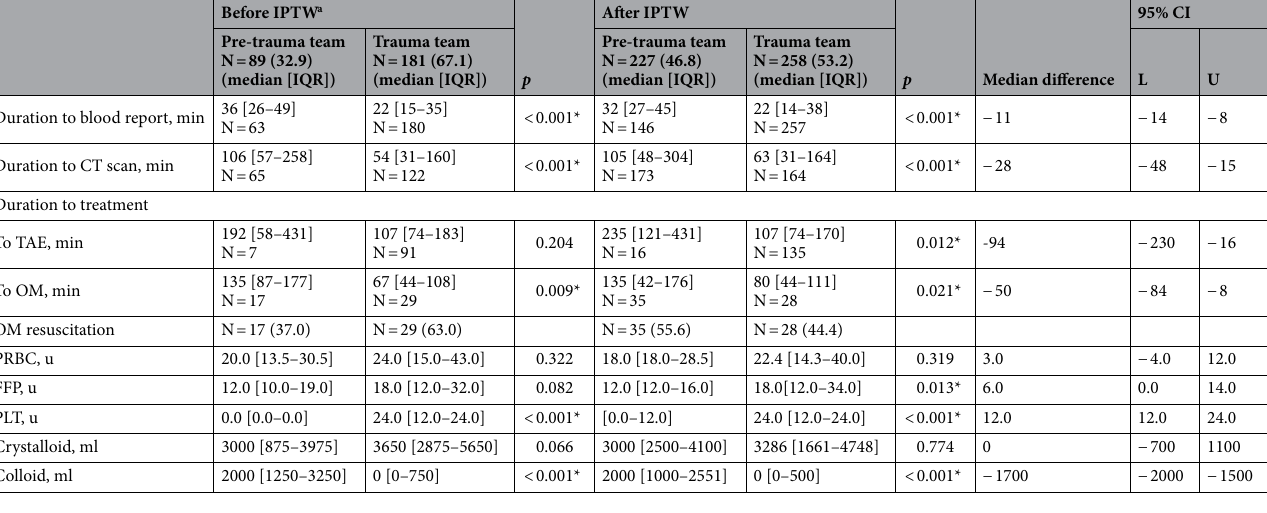
Table 2. Primary outcomes. Significant values are in [bold]. NOM non-operative management; OM operative management; PLT platelet; TAE transarterial embolization. a IPTW model includes sex, age, comorbidity,